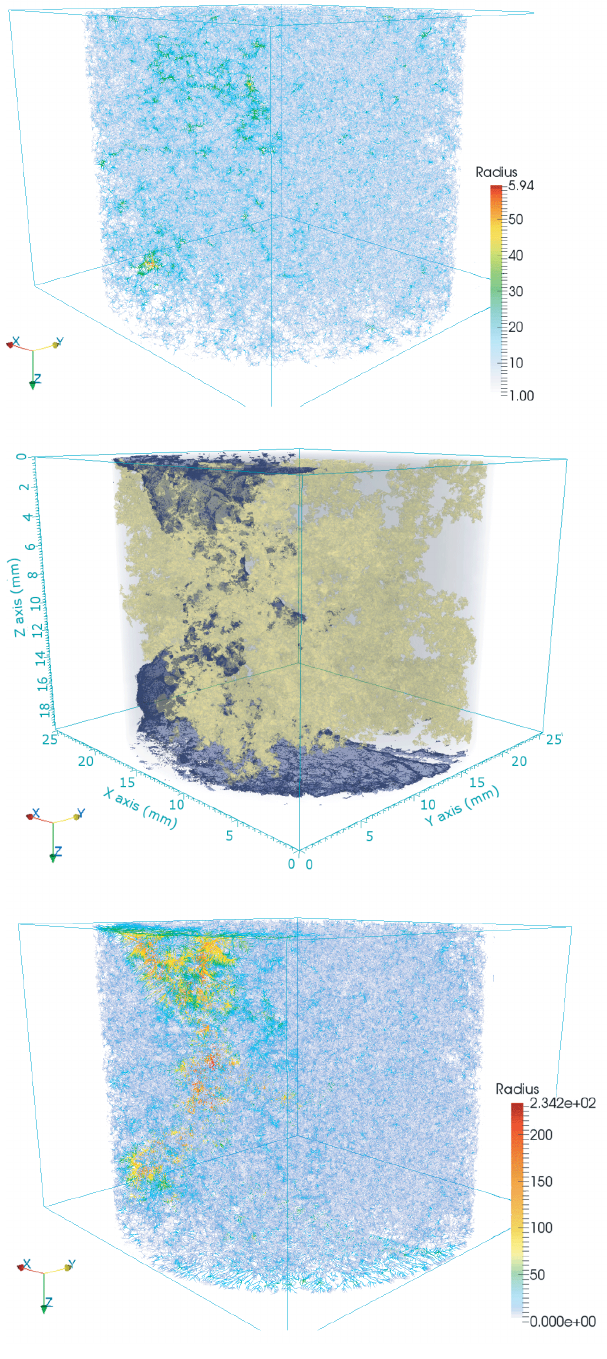
Figure 6. From top to bottom: extracted skeleton on sample Bvl be , the formed wormholed in sample Bvl af (blue) replaced in sample Bvl be where the resolved connected porosity appears in yellow, ex- tracted skeleton on sample Bvl af . For the extracted skeleton images, the blue to red scale colours corresponds to pore-size increase in- dicated in pixels (up to 60pxls for sample Bvl be and 234pxls for sample Bvl af